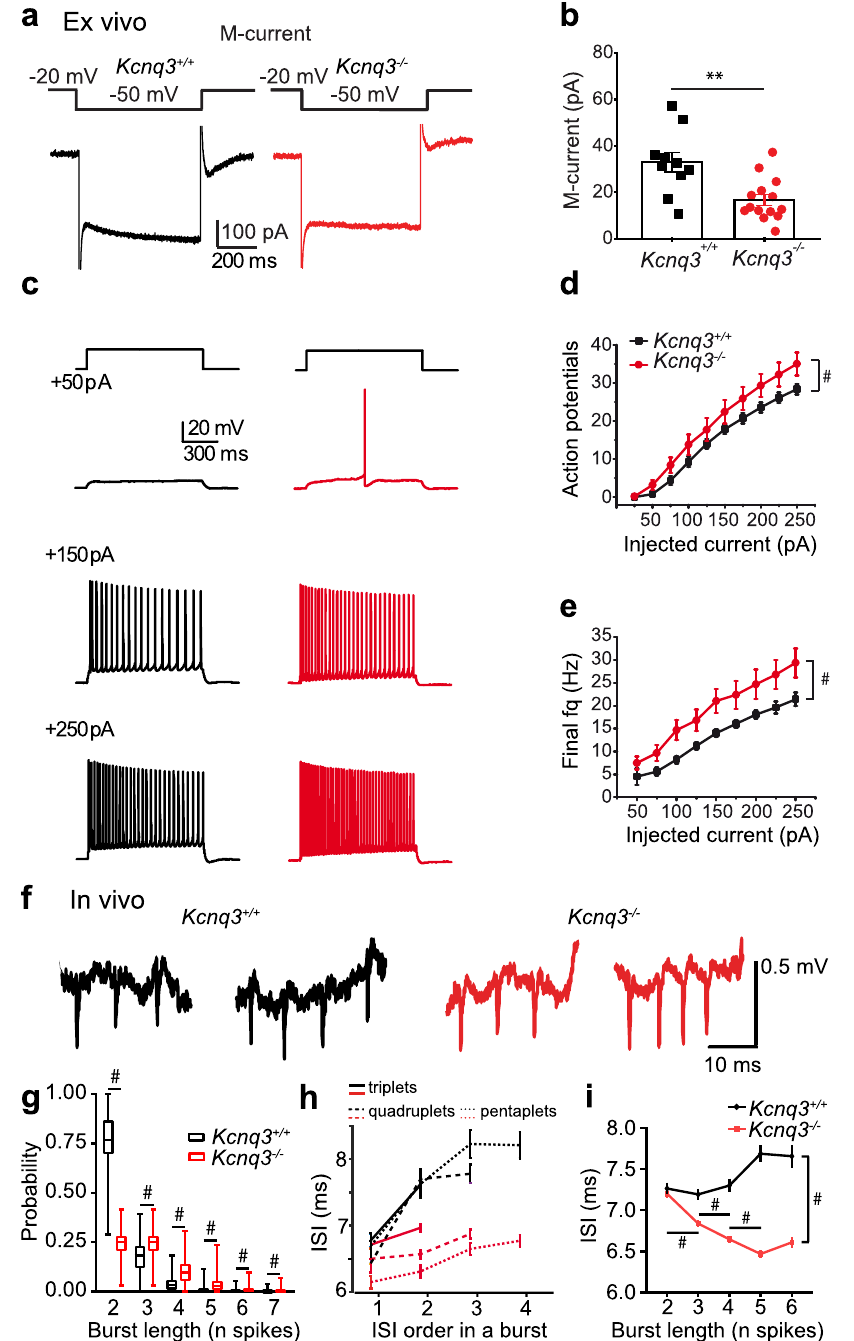
Fig. 1 Kcnq3-containing M-channels contribute to the excitability of pyramidal cells during burst discharge. a Representative responses of CA1 pyramidal cells in hippocampal slices in voltage clamp experiments. b Amplitude of M-current measured as the slow deactivating tail current ( n = 10 cells from 3 Kcnq3 + / + mice, black, n = 14 cells from 4 Kcnq3 − / − mice, red, p = 0.002, t-test). The color code is used for the entire fi gure. c Representative responses of CA1 pyramidal cells in hippocampal slices to intracellular current injections of different magnitudes. d Number of action potentials ( n = 11 cells from 4 Kcnq3 + / + mice, n = 12 cells from 4 Kcnq3 − / − mice, F 1,175 = 30.8, #, p <0.0001, ANOVA) and ( e ) their frequency (calculated for the last two action potentials, n as in ( d ), F 1,164 = 48.6, # p <0.0001, ANOVA) upon injection of 1s long currents of indicated amplitudes. f Extracellular signal traces recorded using a silicon probe in a behaving mouse, showing representative in vivo bursts consisting of 3 and 4 spikes. g Histograms of relative probability of bursts with different number of spikes ( n = 299 cells from 6 Kcnq3 + / + mice; n = 413 cells from 4 Kcnq3 − / − mice; #, p <0.0001, Bonferroni tests). The center line indicates the median, the top and bottom edges indicate the 25th and 75th percentiles, respectively, and the whiskers extend to the maximum and minimum data points. h Spike frequency accommodation: ISI averaged according to their order in bursts containing different number of spikes (triplets, tetraplets and pentaplets). Accommodation rate was lower in Kcnq3 − / − than in controls ( n = 305 cells from 6 Kcnq3 + / + mice; n = 413 cells from 4 Kcnq3 − / − mice; F 1,44766 = 90.0; #, p <0.0001, ANOVA). i Average ISI for bursts of different lengths was progressively shorter with increasing burst length in Kcnq3 − / − but not in controls (burst length x genotype: n = same as in ( h ); F 4,7604 = 18.8, p <0.0001, ANOVA, #, p <0.0001, Bonferroni tests; genotype: F 1,7604 = 195.2, #, p <0.0001). Data shown as mean ± SEM, see also Supplementary Information, Statistical Analysis (Fig. 1d,e, g-i).